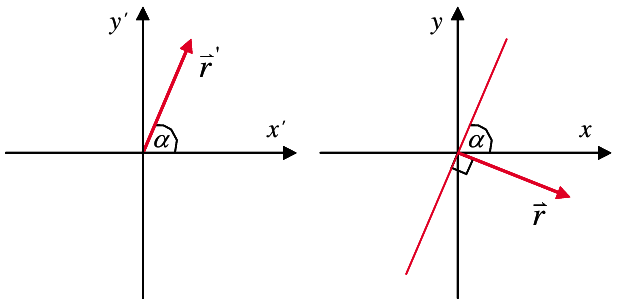
FIG. 6. (Color) Schematic illustrating the effect of a 90 (cid:1) rotation of the betatron planes. A deflection on the first pass (left) is transformed to a displacement which is orthogonal to the de- flection which caused it